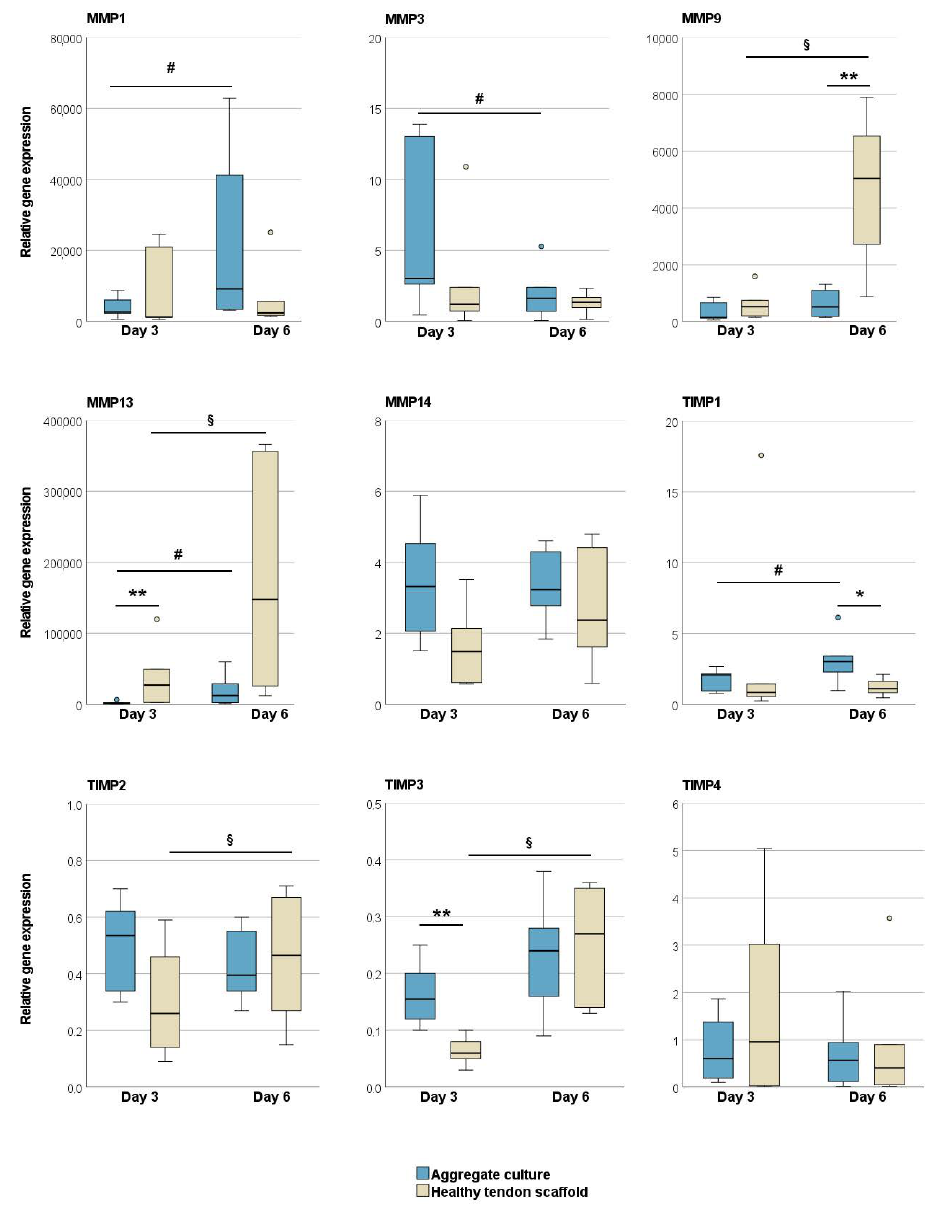
Figure 2. Relative gene expression of matrix metalloproteinases (MMPs) and tissue inhibitors of metalloproteinases (TIMPs) in MSC aggregate cultures and healthy tendon scaffold cultures. Asterisks indicate significant differences between groups with p < 0.05 (*) or p < 0.01 (**). Significant differences over time are indicated by hashmarks for aggregate cultures and by paragraph symbols for healthy tendon scaffold cultures ( p < 0.05). Data were obtained with MSCs from n = 6